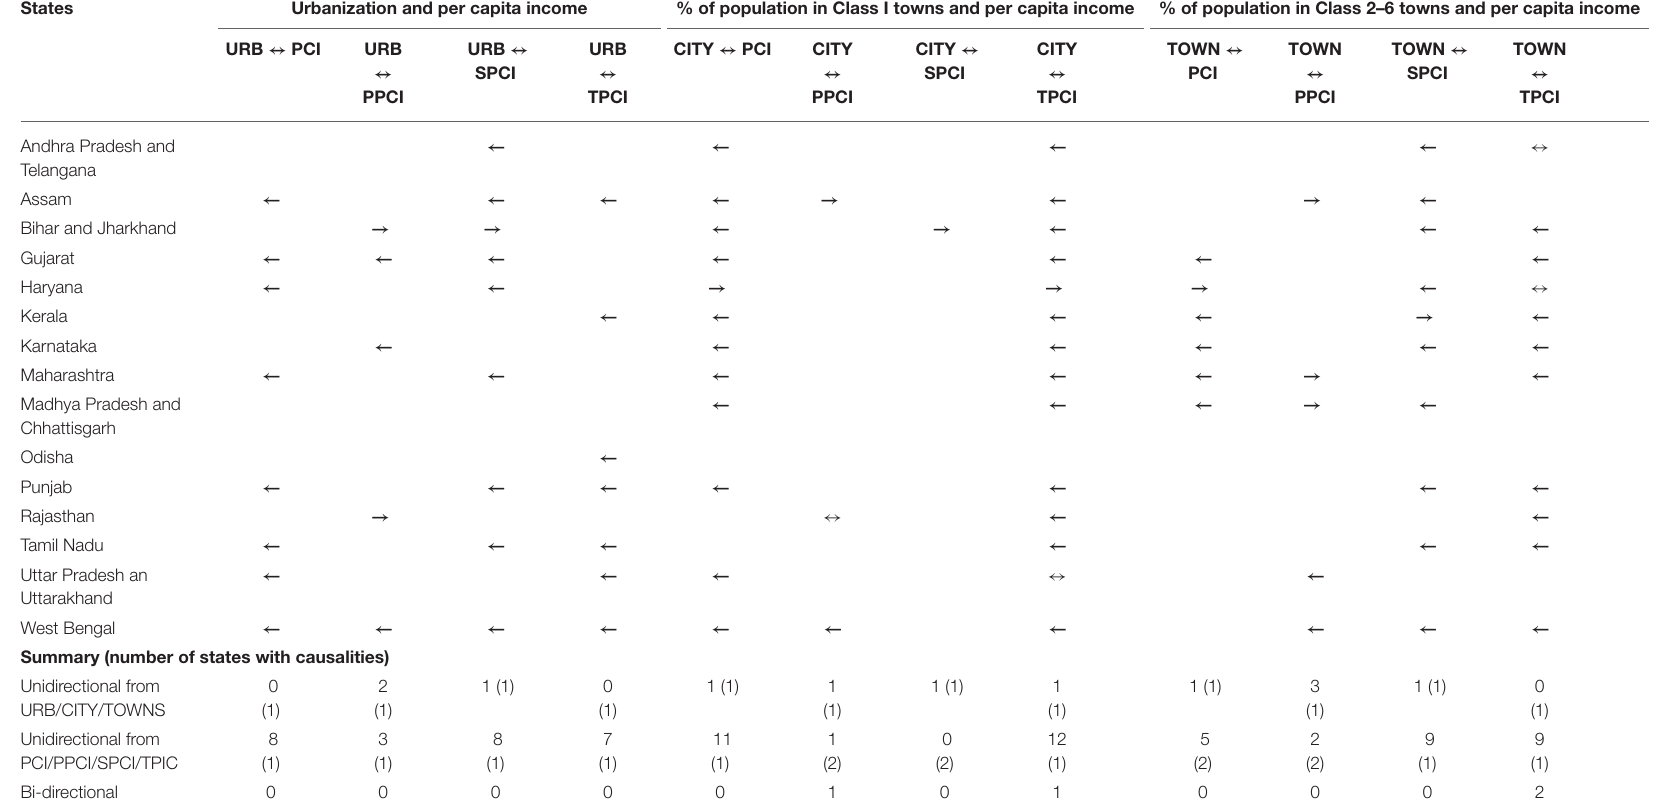
TABLE 4 | Granger causality between the log of urbanization and log of per capita income in Indian states in post-liberalization period (1992–2020).